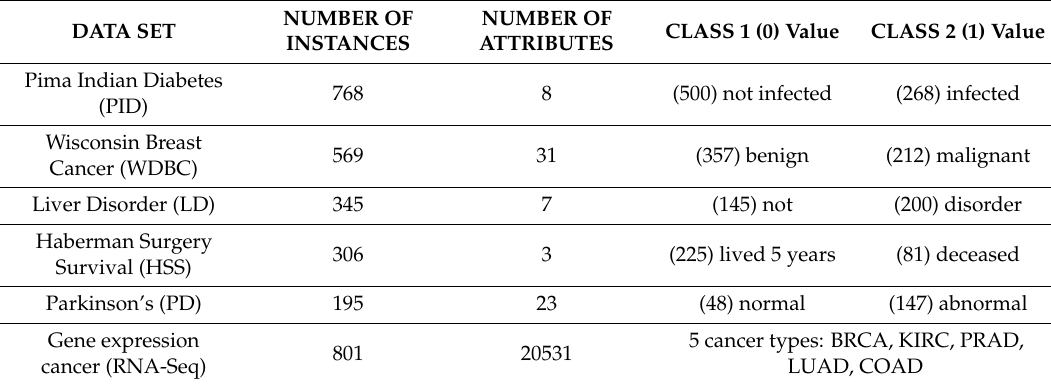
Table 1. Specifications of disease datasets and their attributes’ and classes’